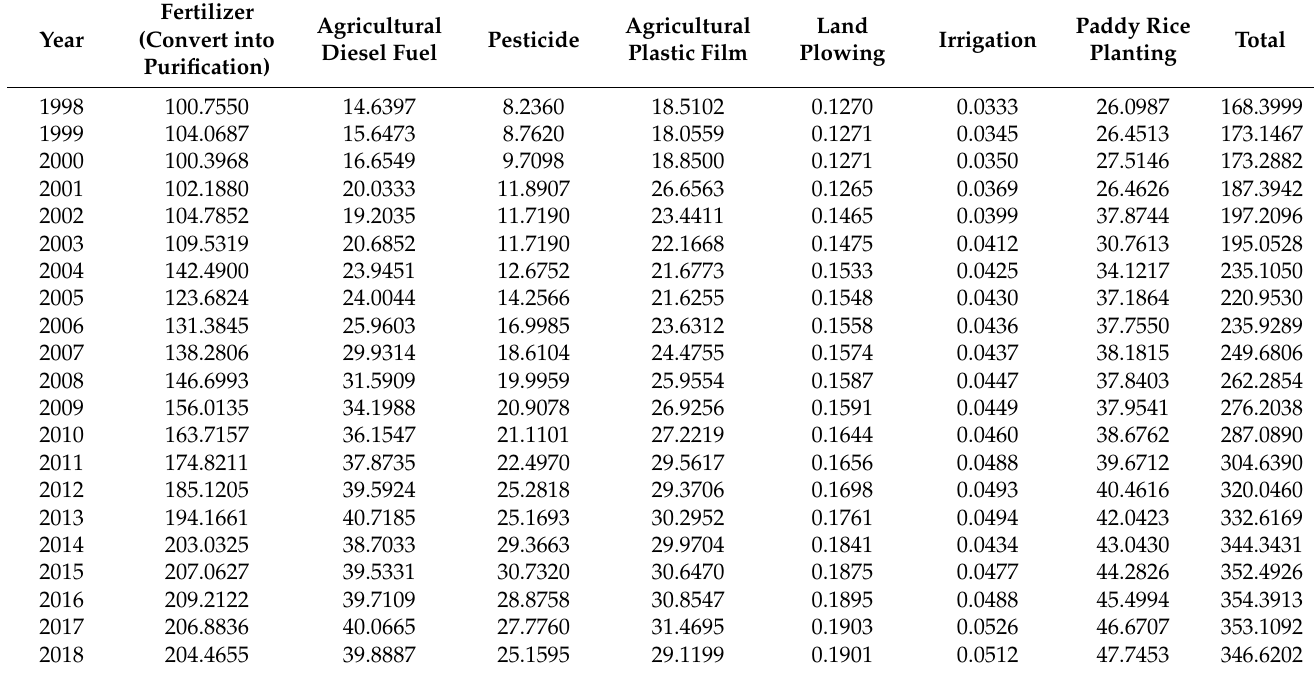
Table 3. Carbon emission of the planting industry in Jilin Province from 1998 to 2018 (unit: 10,000